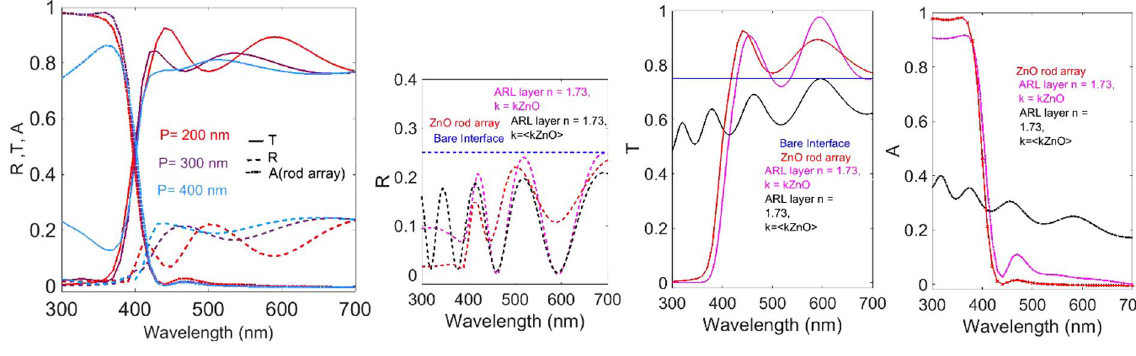
Figure 10. ( a ) Transmission, reflection and rod absorption for different pitches of ZnO nanorod array (radius = 60 nm, length = 200 nm) at the air-dielectric (n = 3) interface ( b ) comparison of reflection, transmission and absorption of the air-dielectric interface in presence of nanorod arrays and planar